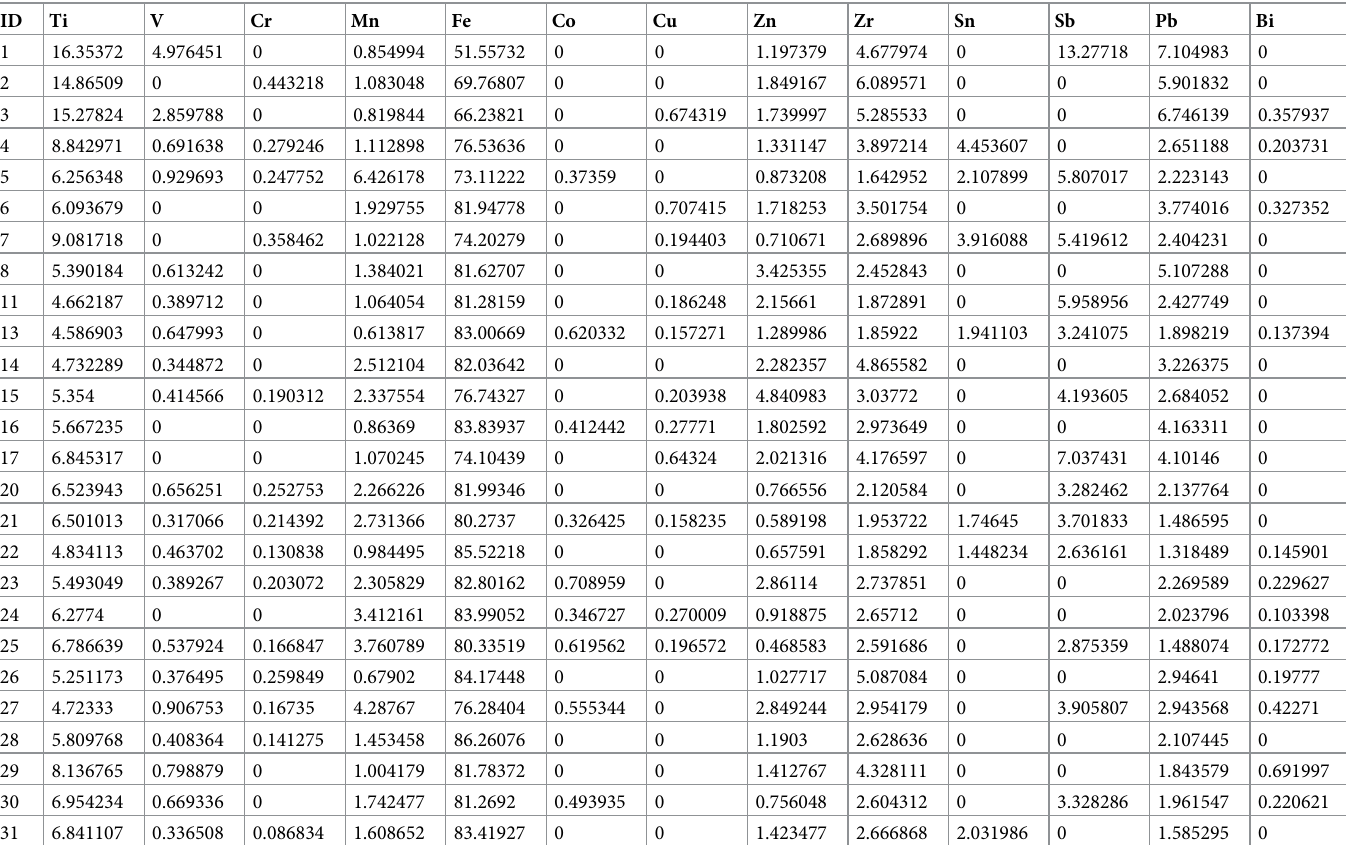
Table 2. Results of the X-ray fluorescence measurements in individual